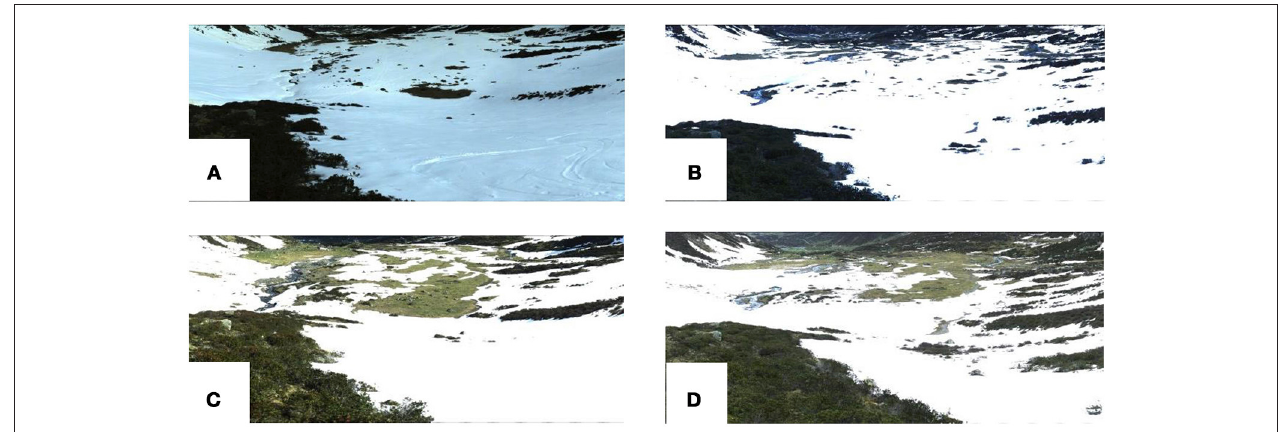
FIGURE A1 | Panoramic images of the Gletschboden area recorded from the scan position for the early ablation period (SCF = 80%) (A,B) and the late ablation period (SCF = 50%) (C,D) . Images on the left are recorded in 2014 (08 May 2014: A ; 21 May 2014: C ) and images on the right are recorded in 2015 (11 May 2015: B ; 16 May 2015: D